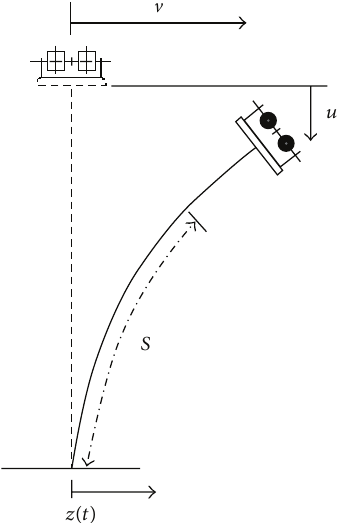
Figure 1: Cantilever model with end mass, coupled gyroscopes, and horizontal base